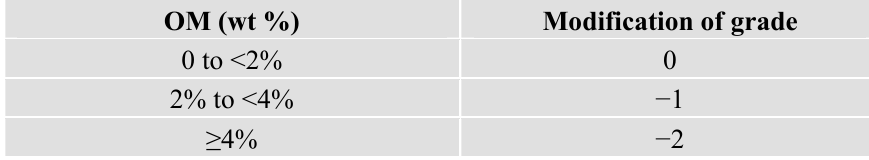
Table 6. Modification of the slaking sensitivity grade due to organic matter (OM)